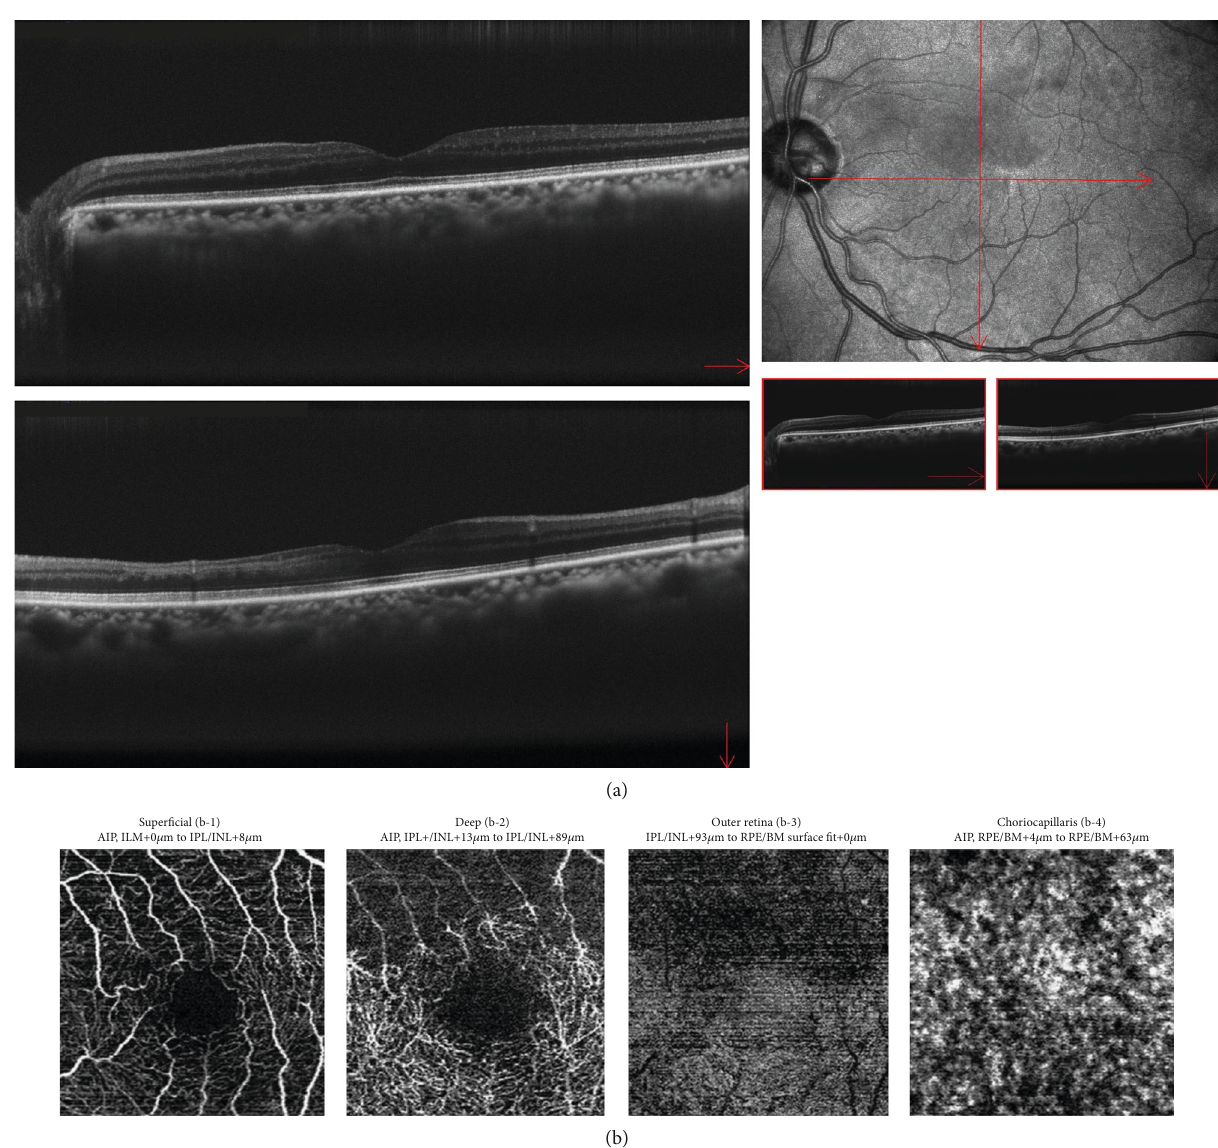
Figure 4: (a) OCT and (b) OCTA at 40 days from disease onset: (b-1) super fi cial layer, (b-2) deep layer, (b-3) outer retina layer, and (b-4) choriocapillaris layer of OCTA. (a) OCT shows thinning of the inner retinal layer consistent with the white change on the fundus photograph. (b) OCTA shows a decrease in the fl ow sign. Compared with at disease onset, the fl ow sign is improved in all layers, but the improvement is mainly in the super fi cial